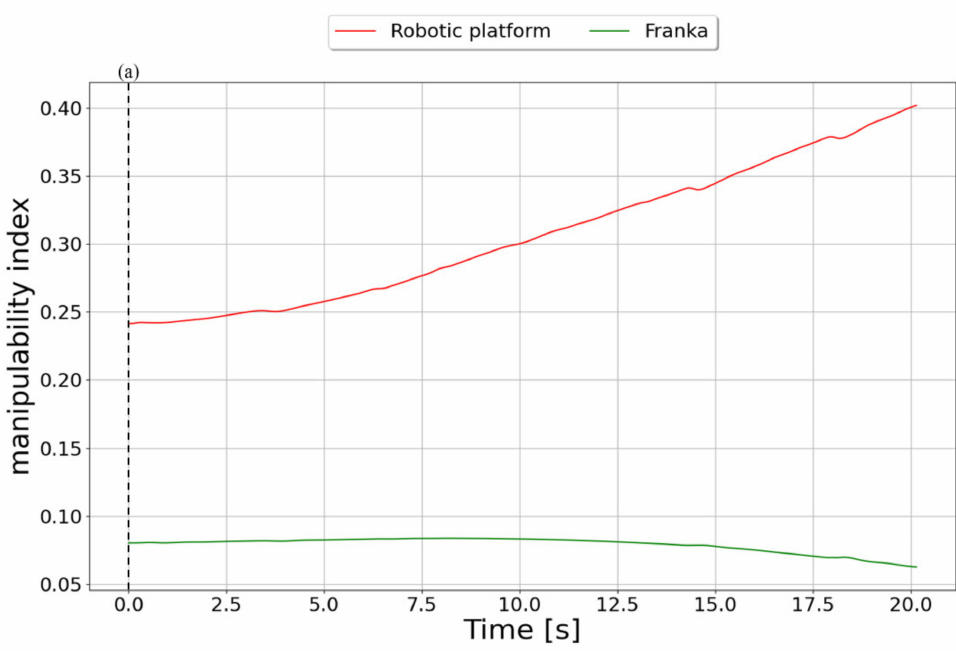
Figure 12. Manipulability Index of the 8-DoF robotic platform and the one of the Franka cobot (7-DoF) during the execution of a linear trajectory along the Y - axis